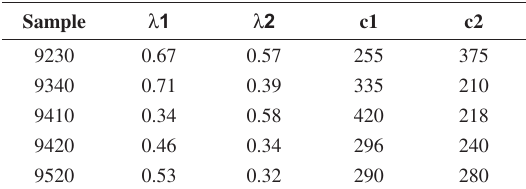
Figure 1. Experimental hardness profile for 9520 and a curve calculated using Equation Table 1. Parameters describing the hardness transitions of the samples studied.